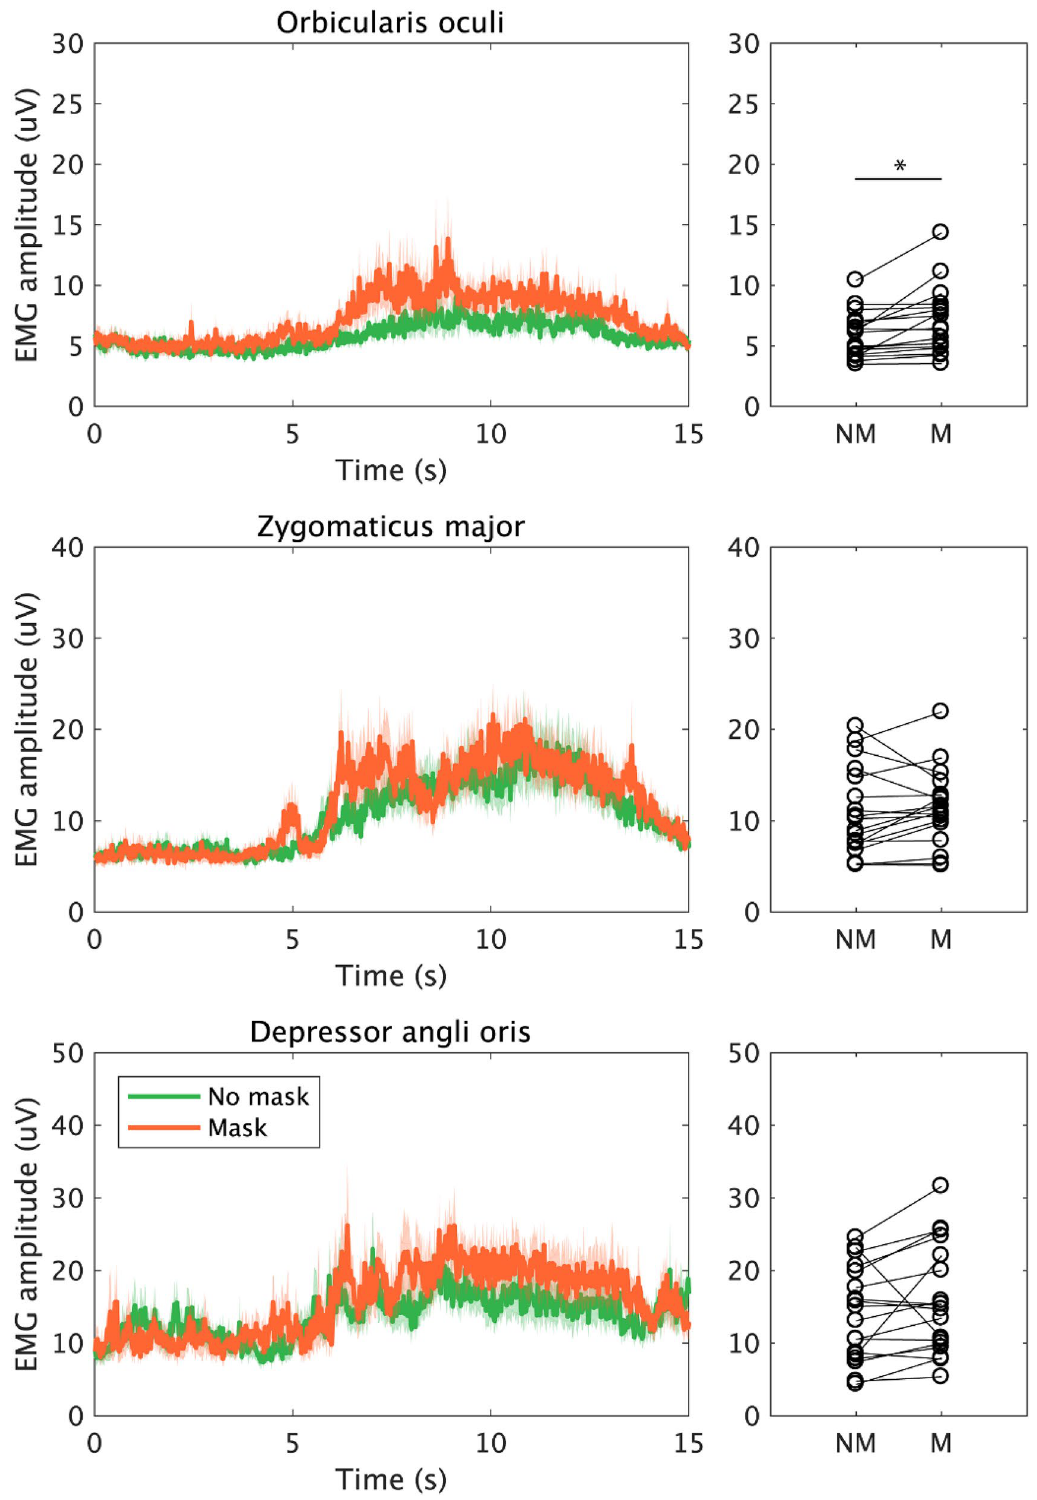
Figure 2. EMG signal measured over orbicularis oculi, zygomaticus major, and depressor anguli oris, during the photo task. The graphs in the left column indicate the time series of EMG signal of these muscles that were integrated with each 20-ms time window (sampling rate was 50 Hz). The solid line is the averaged EMG and the coloured area indicates a standard error of the mean (SEM) across participants. Orange and green lines indicate the EMG signal when the participants wore the mask and when they did not, respectively. Right columns indicate comparisons of averaged EMG during the whole task (15 s) when the participants wore the mask (M) and when they did not (NM). An asterisk indicates a significant difference in the averaged EMG between NM and M conditions (Wilcoxon signed-rank test with a Bonferroni